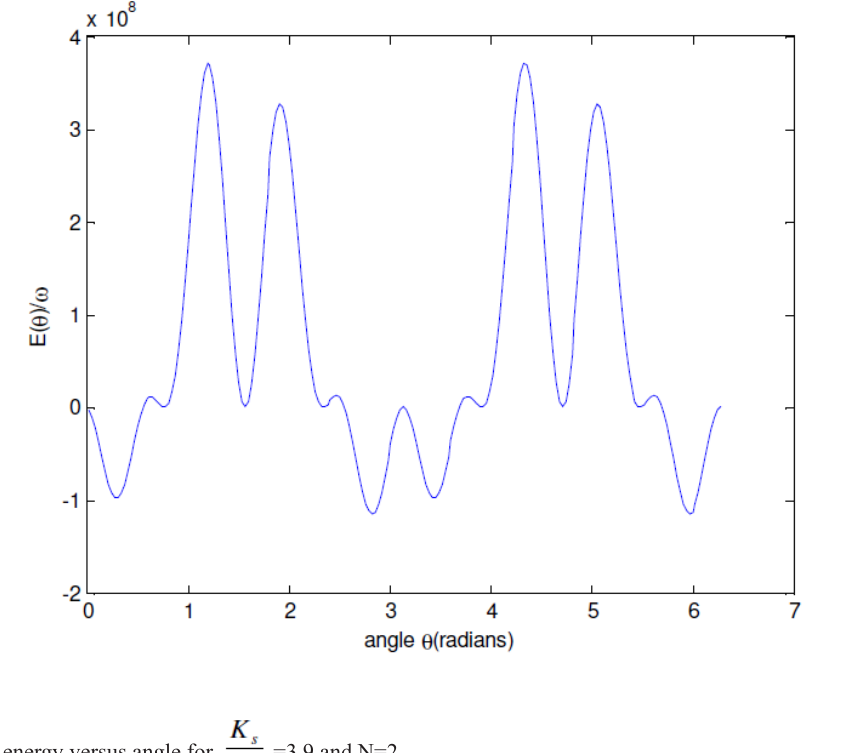
Figure 2: Graph of energy versus angle for =3.9 and